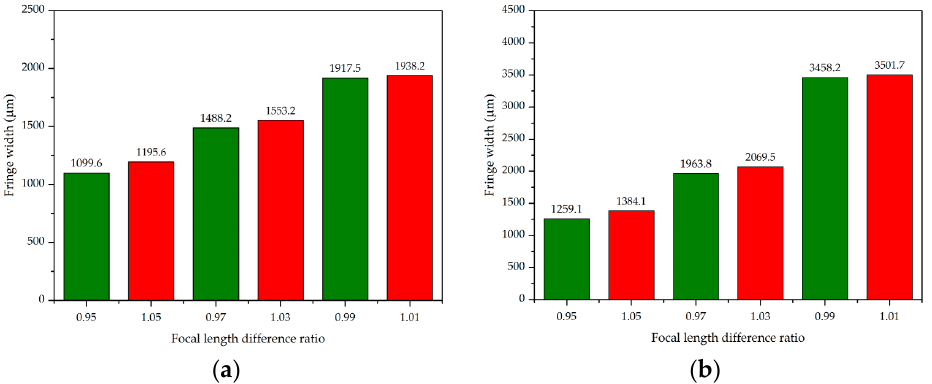
Figure 4. Variation of moir é fringe width at di ff erent focal length ratios of f 1 and f 2 : ( a ) rotation angle of G 2 is 1 ◦ , ( b ) rotation angle of G 2 is 2 ◦ , where the green box represents f 2 > f 1 and the red represents f 2 < f 1